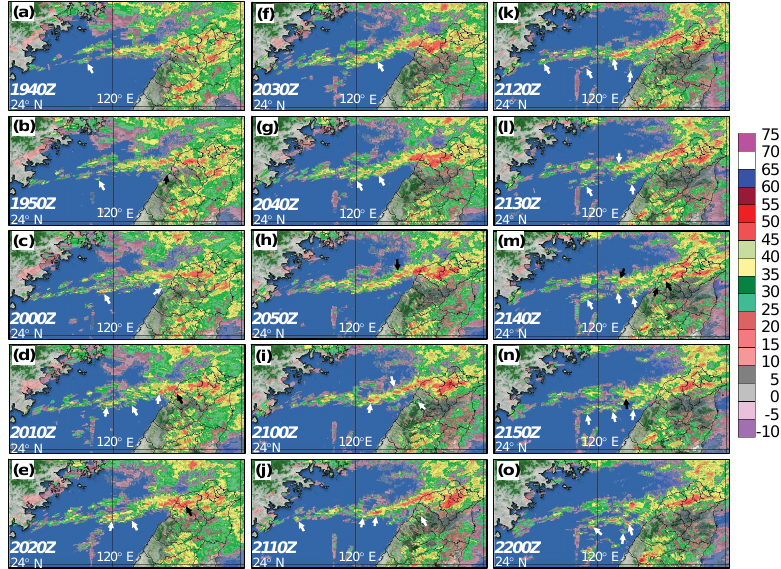
Figure 6. As in Fig. 4, but showing reflectivity over northern Taiwan and the upstream area every 10min from (a) 19:40UTC to (o) 22:00UTC on 11 June 2012 using a different set of colors. The arrows mark the initiation or strengthening of back-building cells, off the western end of a rainband or upstream from an old